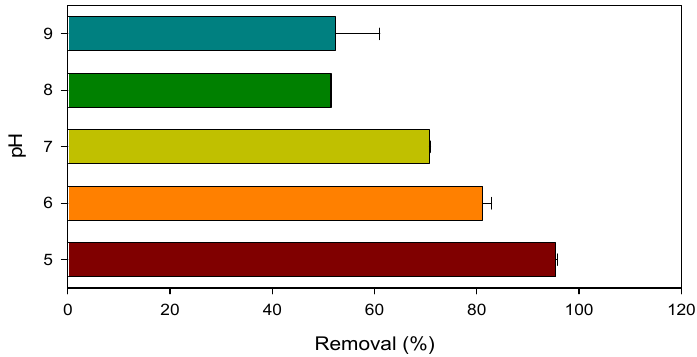
Figure 6. Removal of CBZ by the Mn(III)/HSO 3 − process under the pH range of 5.0–9.0. Conditions: [CBZ] 0 = 5 µM, [NB] 0 = 1 µM, [Mn(III)] 0 = 50 µM, [PP] 0 = 2.5 mM, [HSO 3 − ] 0 = 250 µM.